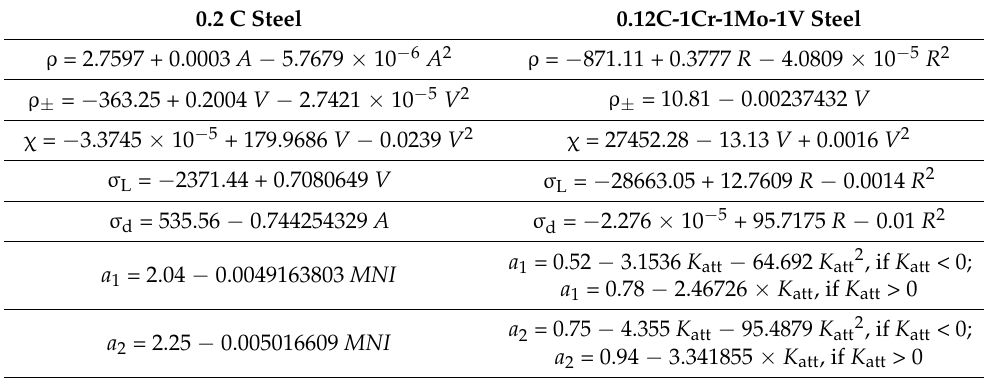
Table 6. Dependences of structural and deformation parameters on acoustic and magnetic charac- teristics.